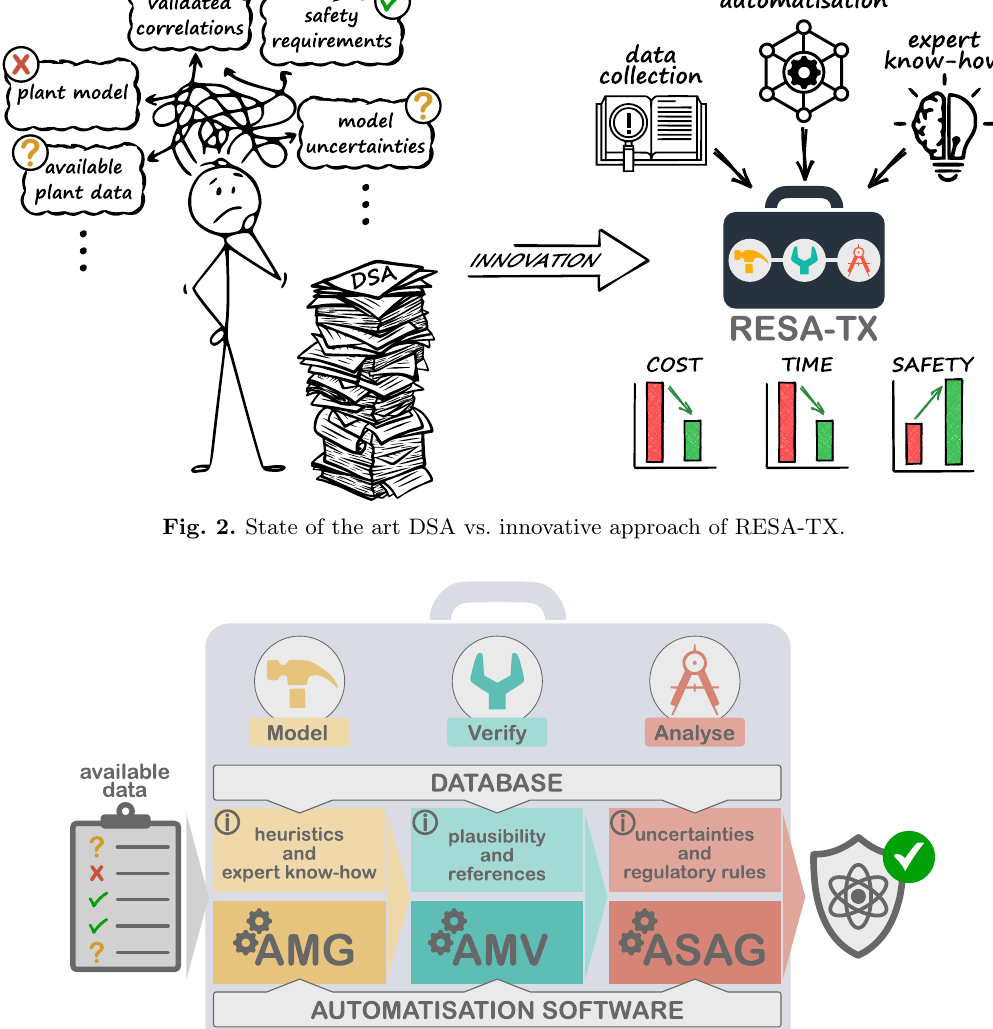
Fig. 3. The REactor Safety Analysis ToolboX